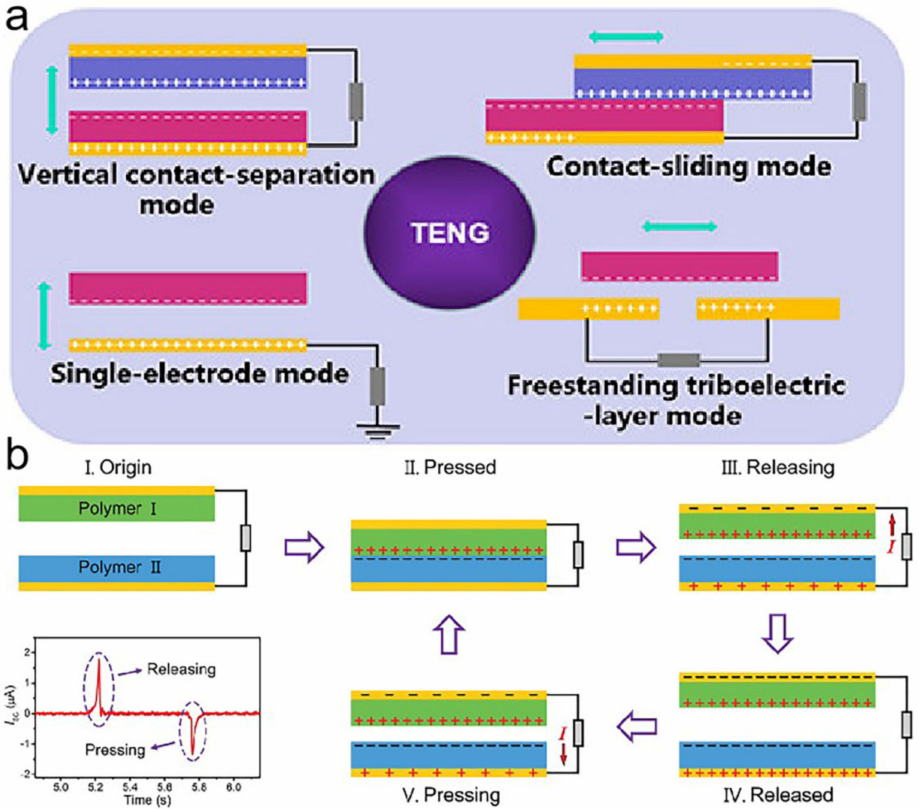
Figure 1. ( a ) The TENG’s four working modes. Reprinted with permission from Ref. [50]. Copy- right 2021 American Chemical Society. ( b ) Schematic diagram of working principle of TENG in vertical contact-separation mode. Reprinted with permission from Ref. [1]. Copyright 2021 Wiley Online